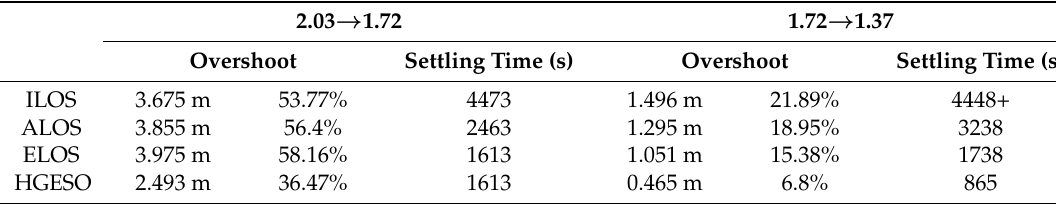
Table 3. Comparison of overshoot and settling time at y d = 0.05 L .